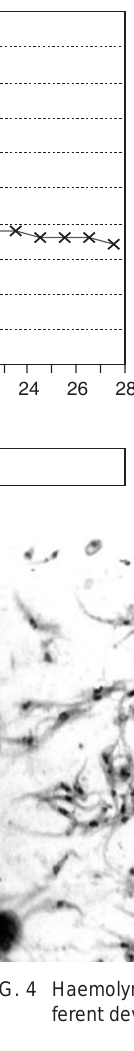
FIG. 2 Trypanosoma theileri parasitaemia and PCV in the infected calf